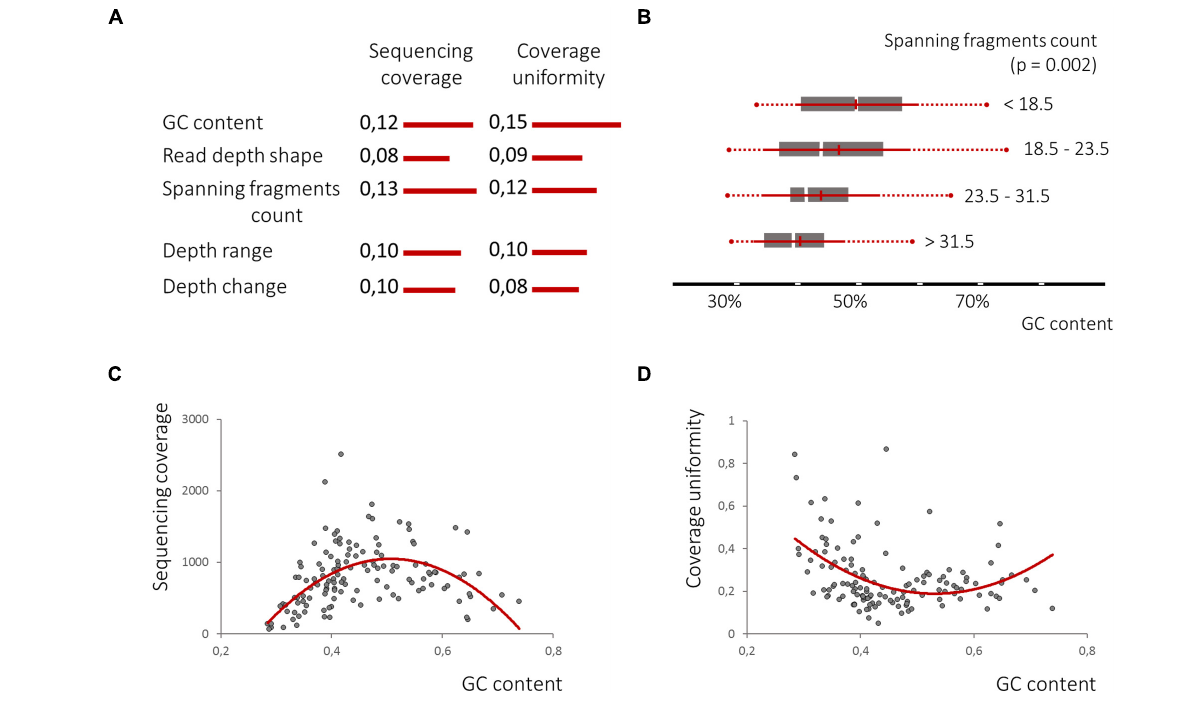
FIGURE 6 | The nucleosome-guided cfDNA fragmentation pattern influences amplicon mean coverage and its uniformity across samples. (A) . RReliefF ranking of the defined features in relation to amplicon mean coverage and its uniformity across samples listed in comparison with GC content ranks, previously shown to have strong non-linier correlation with both dependent variables (C,D) , demonstrates the significance of all four features for the prediction of target variables, though linear correlation between spanning fragment counts and GC content was observed (B)